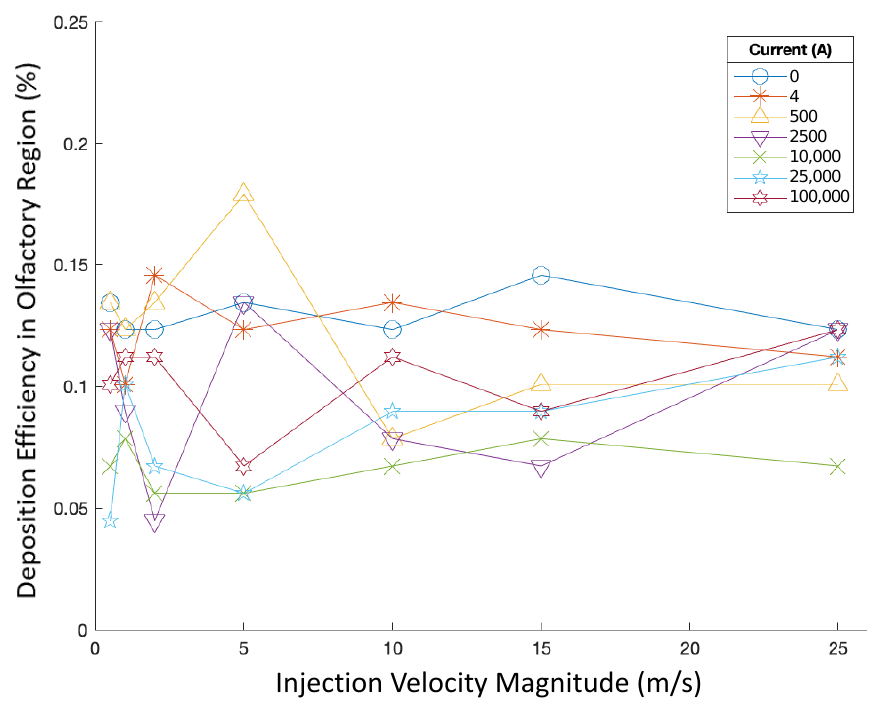
Figure 5. Deposition efficiencies in varying magnetic fields for varying injection